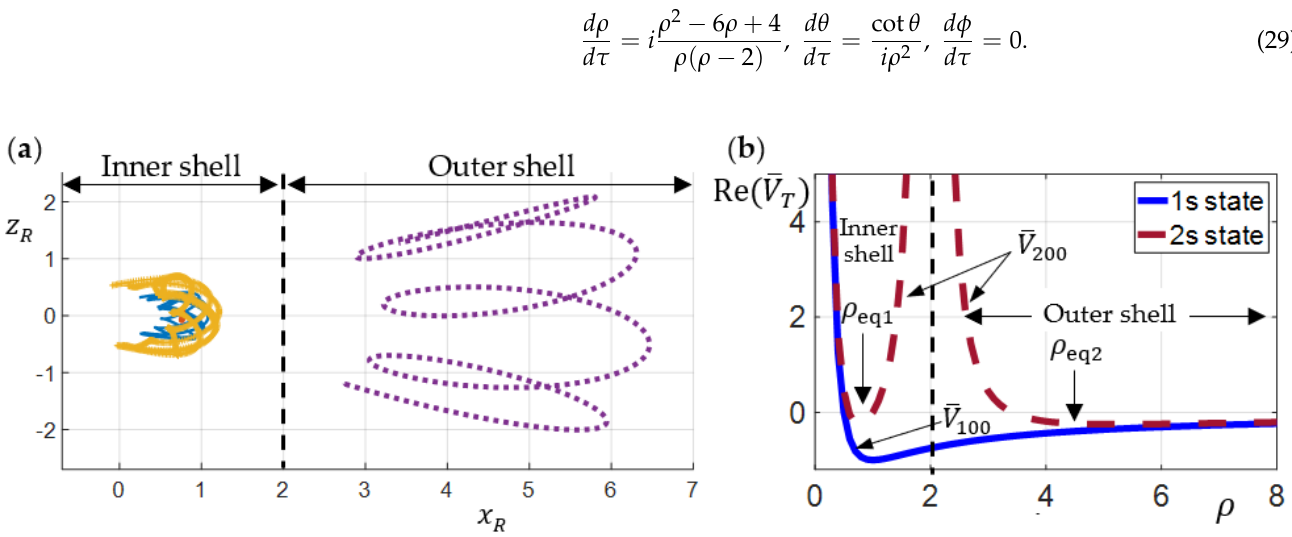
Figure 2. ( a ) The Electron’s trajectory in the real x - z plane with initial positions (𝜌(0),𝑧 𝜃 (0)) = (0.4,0.8) , ( 3 − √5,0.1 ), (1,−0.7) , and (3, −0.4) are represented, respectively, by solid-blue line, solid-red line, solid-yellow line, and dashed-purple line. ( b ) The real-part total potential in the 1s state and 2s state, 𝑉̅ 100 and 𝑉̅ 200 , has the equilibrium radius at 𝜌 eq = 1 and 𝜌 eq = 3 ± √5 , respec-tively.